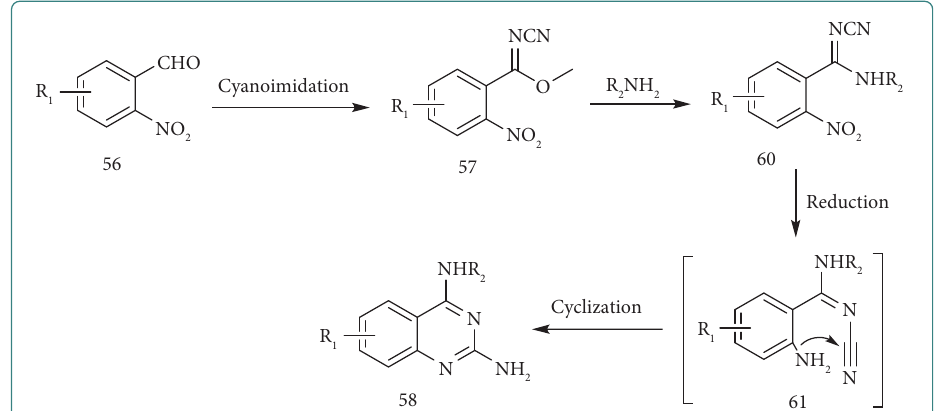
Figure 9: Te proposed mechanism for the synthesis of N 4 -substituted 2,4-diaminoquinazolines in the presence of H